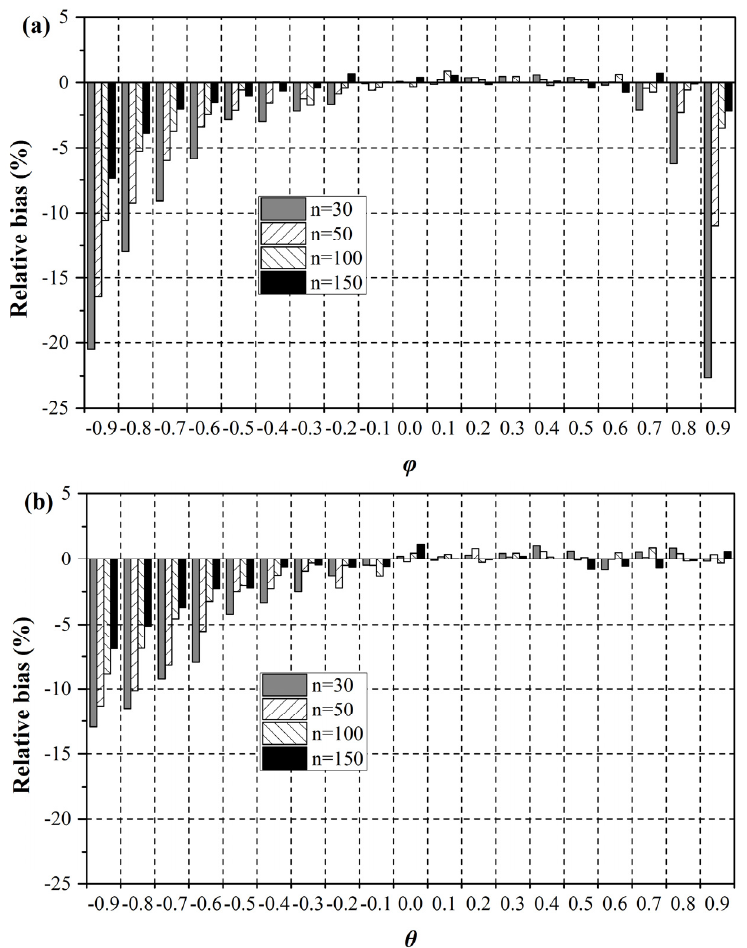
Figure 3. The relative bias of the rho variance calculation via the newly proposed theoretical formula: ( a ) AR(1); ( b ) MA(1).